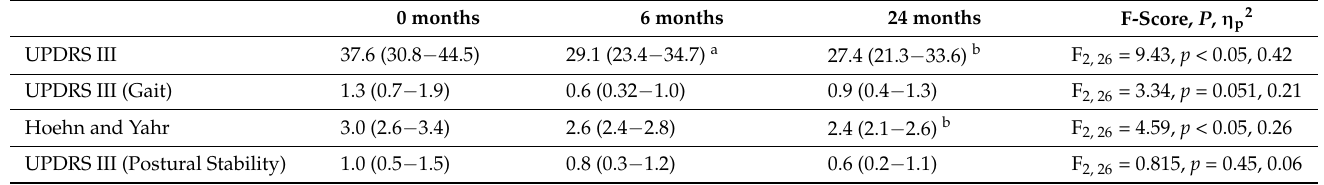
Table 1. Means, (95% Confidence Interval) of clinical scales at baseline (0 month), 6 and 24 months post-surgery.